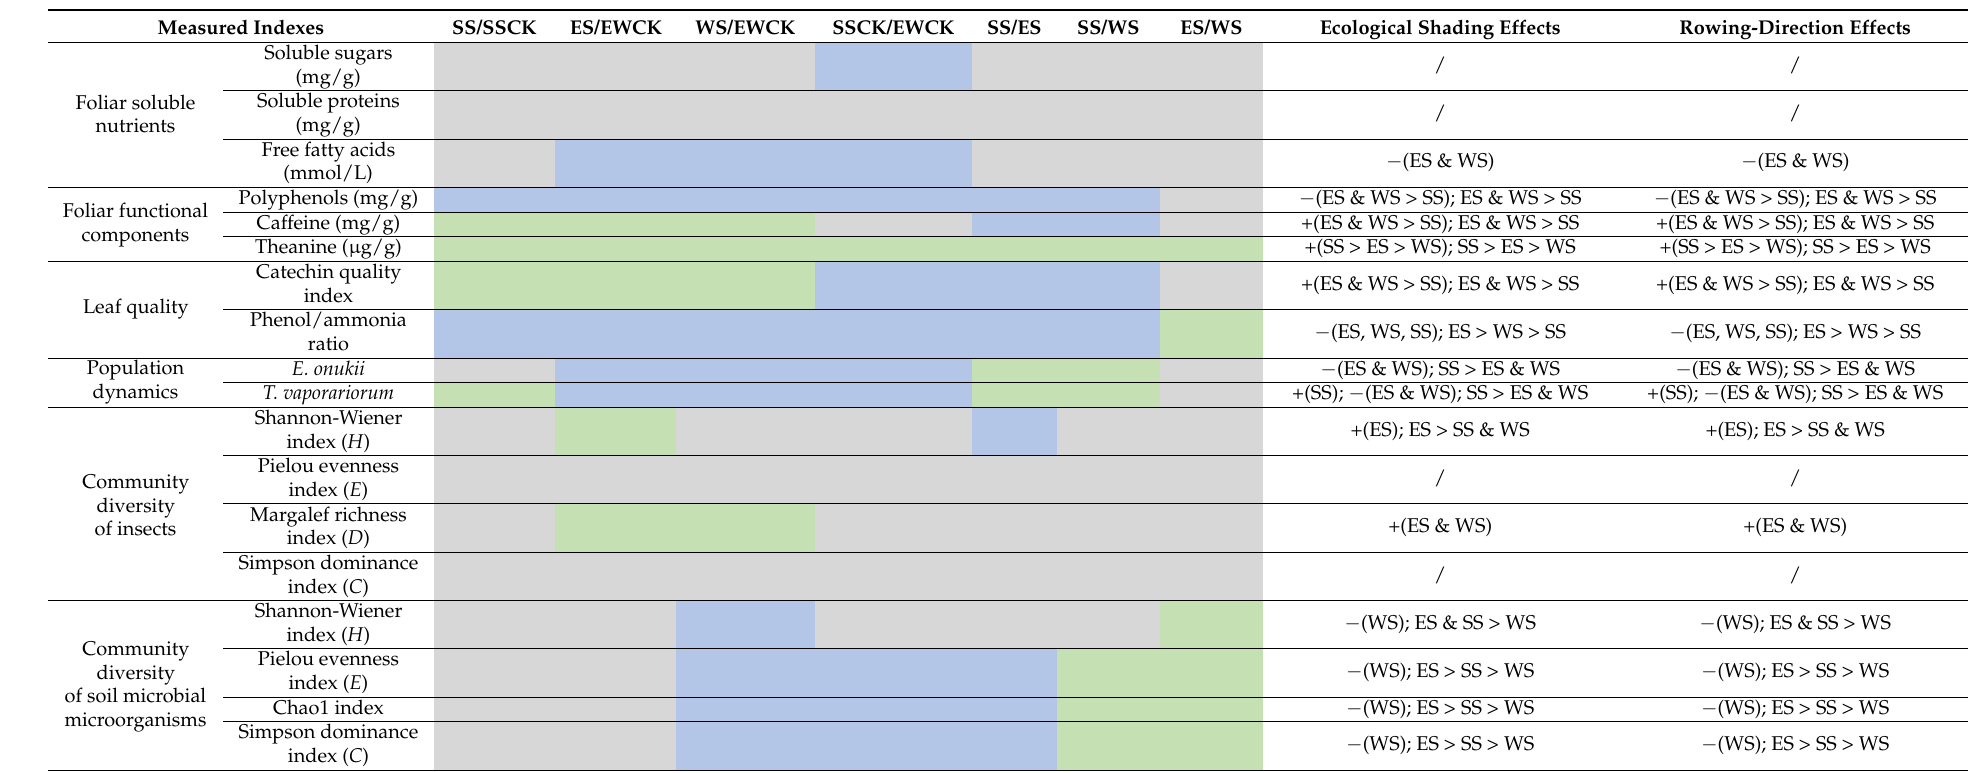
Table A2. Summary about the effects of ecological shading treatment (SS vs. SSCK; ES and WS vs. EWCK; SS vs. ES vs. WS) and rowing direction (SSCK vs. EWCK) on the foliar contents of soluble nutrients, functional components and leaf quality indexes of tea plants, and population dynamics of two key insect species of E. onukii and T. vaporariorum , and community indexes of insects and soil microbial microorganisms in tea plantation.